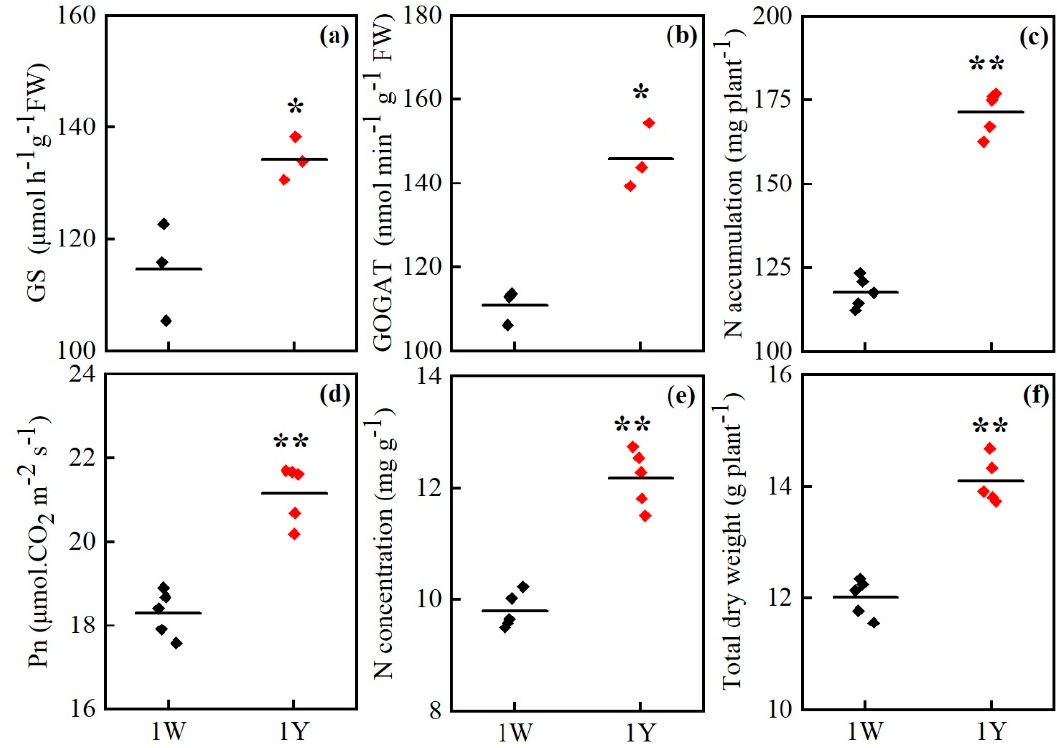
Figure 1. Growth performances of the two wheat genotypes at the anthesis stage under normal nitrogen conditions. Results are shown as means ± SD. ( a ) GS activity; ( b ) GOGAT activity; ( c ) N accumulation; ( d ) net photosynthetic rate ( Pn ); ( e ) N concentration; ( f ) Total dry weight. ♦ and ♦ refer to the replicates of 1W and 1Y, respectively. * and ** mean the significant difference at the p < 0.05 and p < 0.01, respectively.